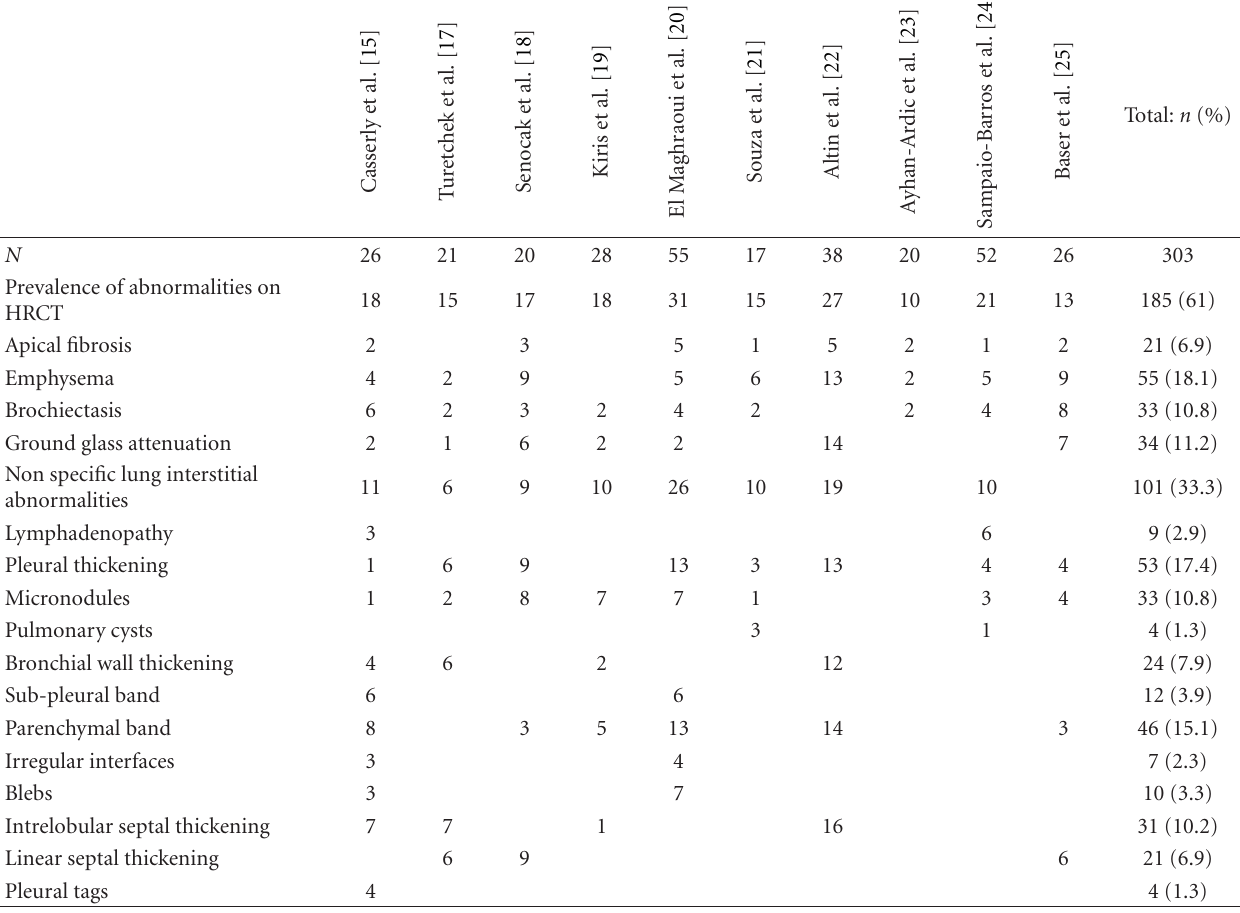
Table 1: Prevalence of thoracic HRCT abnormalities in patients with AS.